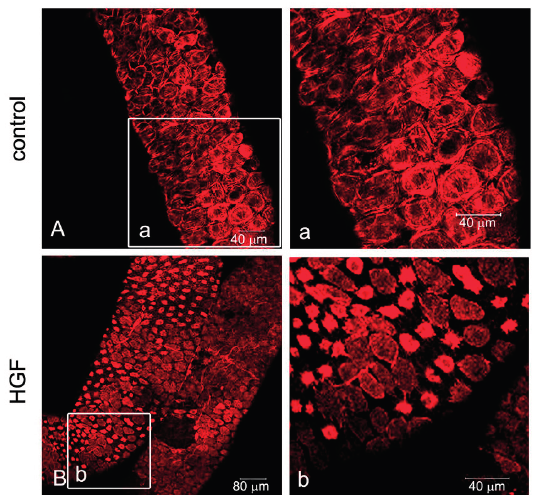
Figure 3. Confocal analysis of F-actin cytoskeletal modifications in cultured pubertal rat seminiferous tubules. The figure shows the F-actin cytoskeletal pattern of pubertal rat seminiferous tubules cultured for 24 h in medium alone (control) ( A , a ) or in the presence of HGF ( B , b ). Lower magnification ( A , B ) and higher magnification ( a , b ) of the images are shown.